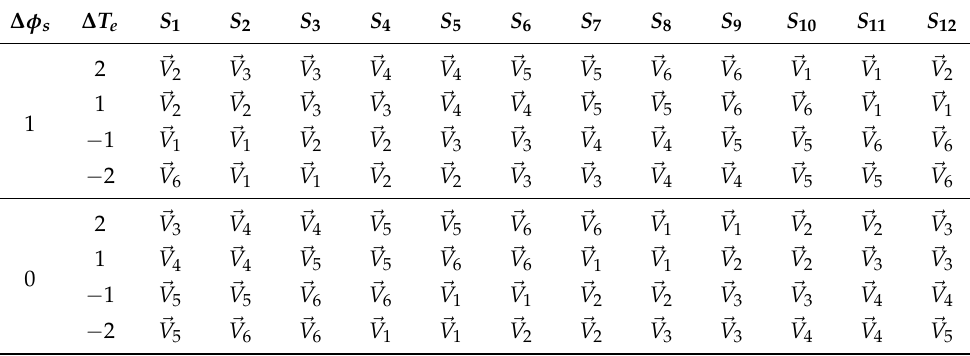
Table 2. Switching table of the proposed twelve-sector